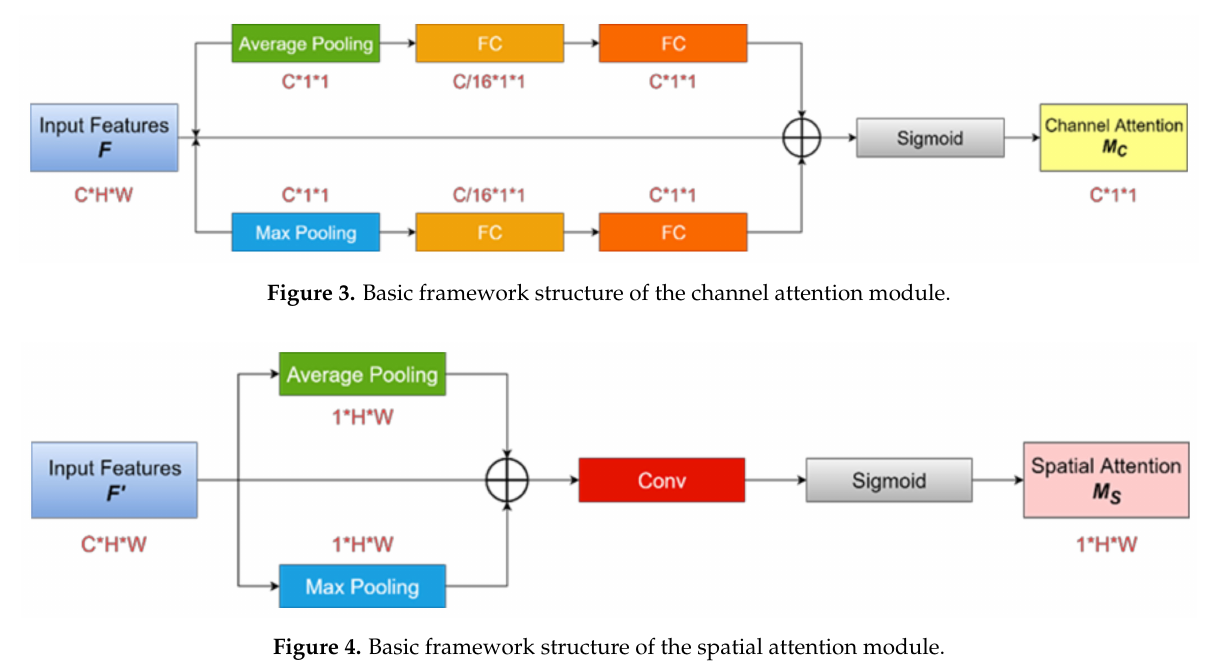
Figure 4. Basic framework structure of the spatial attention